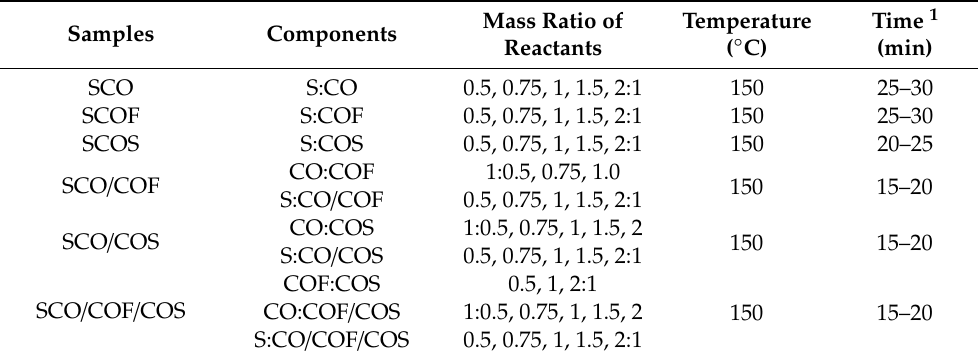
Table 1. The preparing conditions of the resulting polysulfide-derived